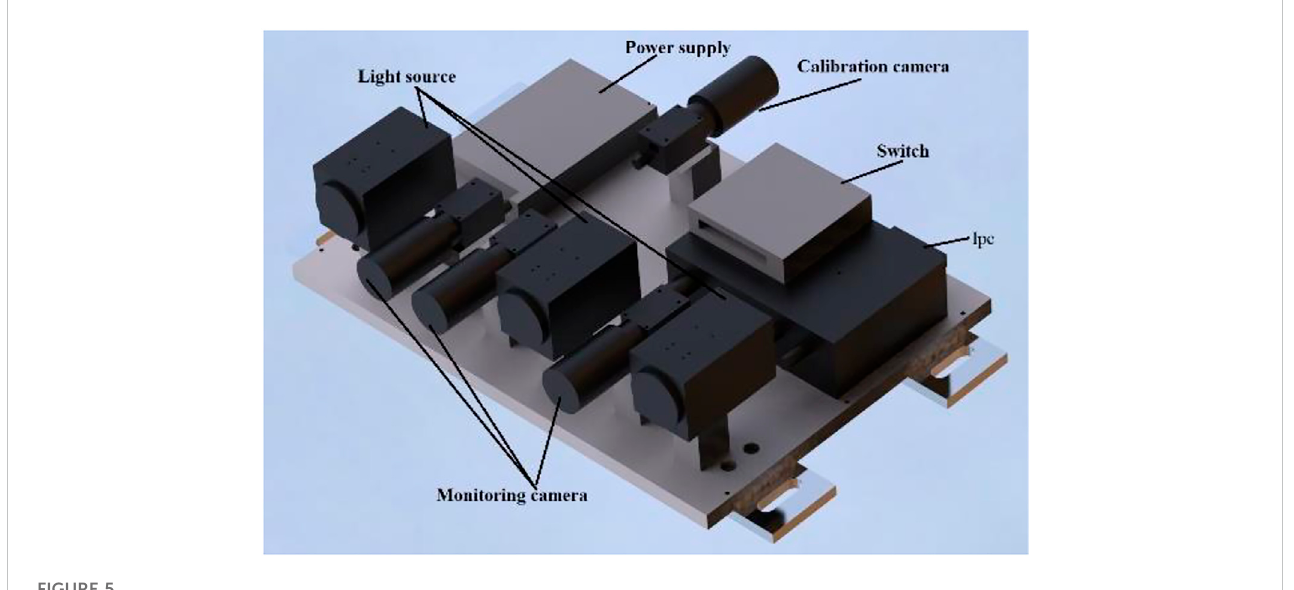
FIGURE 5 Design scheme of back to back measuring station.